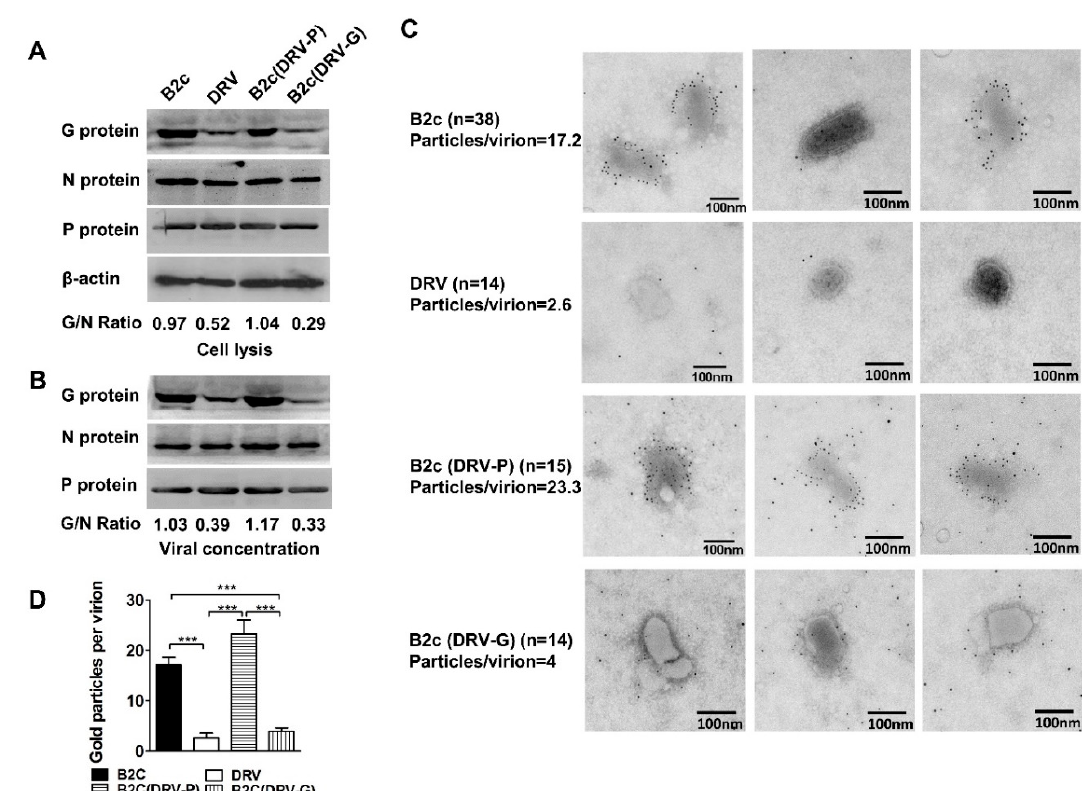
Figure 1. Expression of RABV-G in NA cells and G incorporation into virions. ( A ) Western blot of viral protein expression in NA cells infected with indicated RABVs at MOI 1. ( B ) Western blot analysis of viral protein incorporated into virions. The ratio between G and N was calculated from the intensity of the band using Image-Pro Plus 6.0. ( C ) Electron micrographs of the indicated RABV virions purified from the supernatants of infected NA cells. RABV-G protein was detected by staining with RABV-G-specific antibodies labeled with 5-nm immunogold particles. ( D ) The number of gold particles per virion was calculated by manual counting of positive gold dots. Significance of differences between the gold particles per virion of the indicated virus was assessed by the unpaired t -test. *, p < 0.05; **, p < 0.01; ***, p < 0.001.